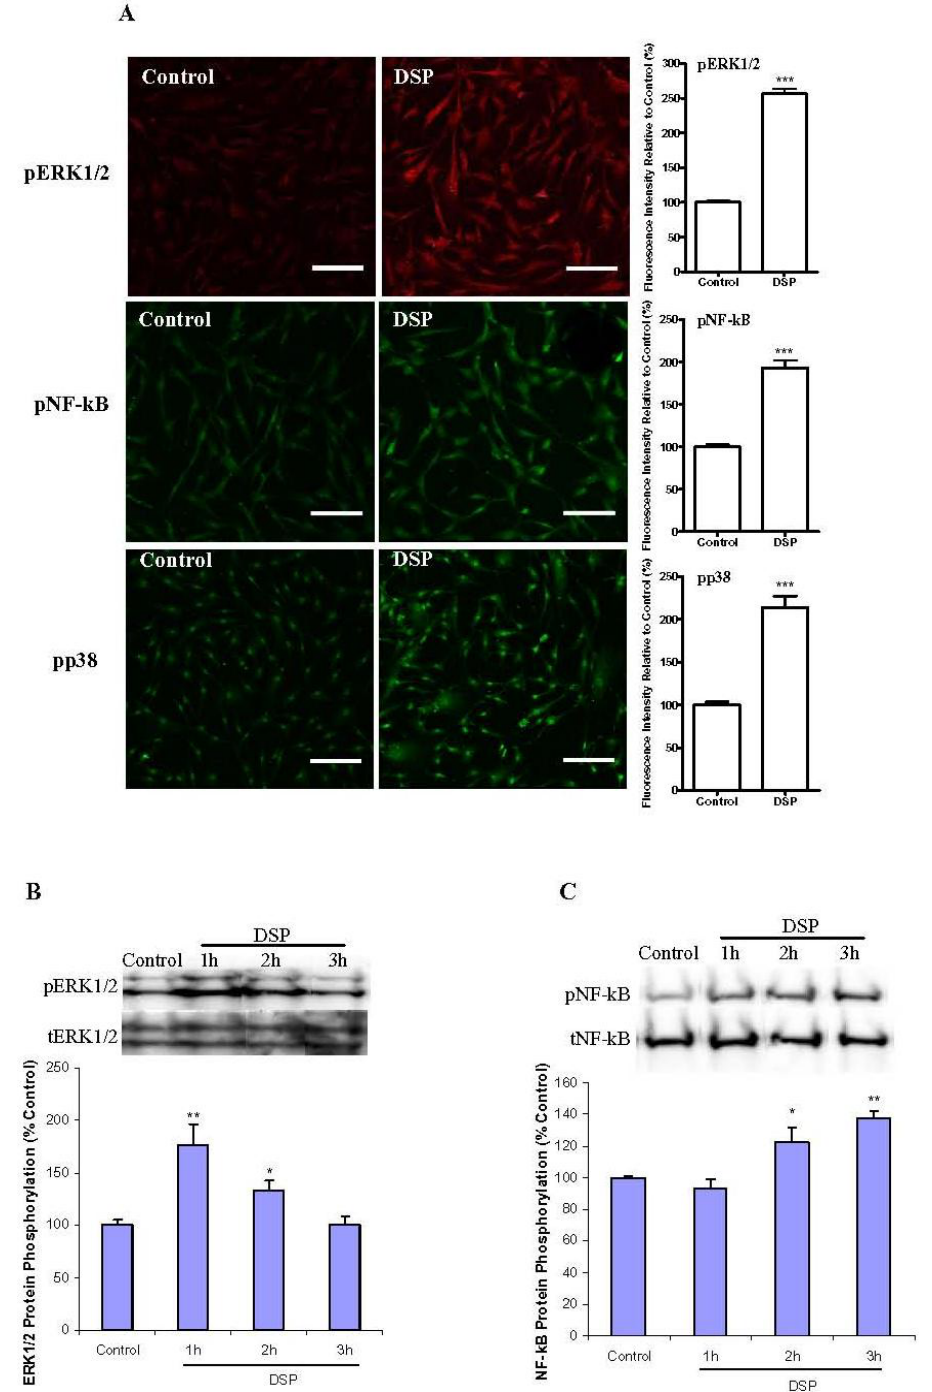
FIGURE 2. DSPs enhance phosphorylation of ERK1/2, NF-κB, p38, and Elk-1 in human VSMCs. Serum- starved cells were treated with 0.2 μl/ml of DSPs for 1, 2, or 3 h. (A) Bar graphs show the results of statistical analysis of the fluorescence intensities for phosphorylated ERK1/2, NF-κB, and p38 from samples treated with DSPs for 2 h. The left panels indicate representative images of immunofluorescence. The scale bar in each image represents 20 μm. (B and C) Bar graphs show DSP-induced time-dependent activation of ERK1/2 (B) and NF-κB (C). The upper panels indicate representative autoradiographs of western blot. Data represent mean ± S.E.M. * p < 0.05, ** p < 0.01, *** p < 0.001 vs. control; p = phosphorylated; t =